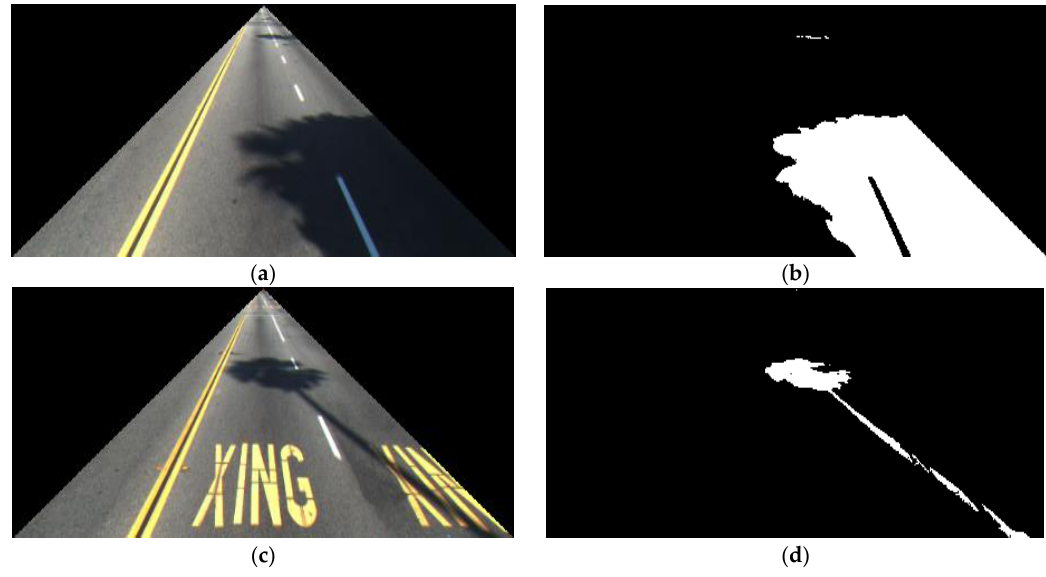
Figure 8. Examples of extracted shadows for calculating feature 2: ( a , c ) Image in the ROI; ( b , d ) binarization image of detected shadow by Figure 7.